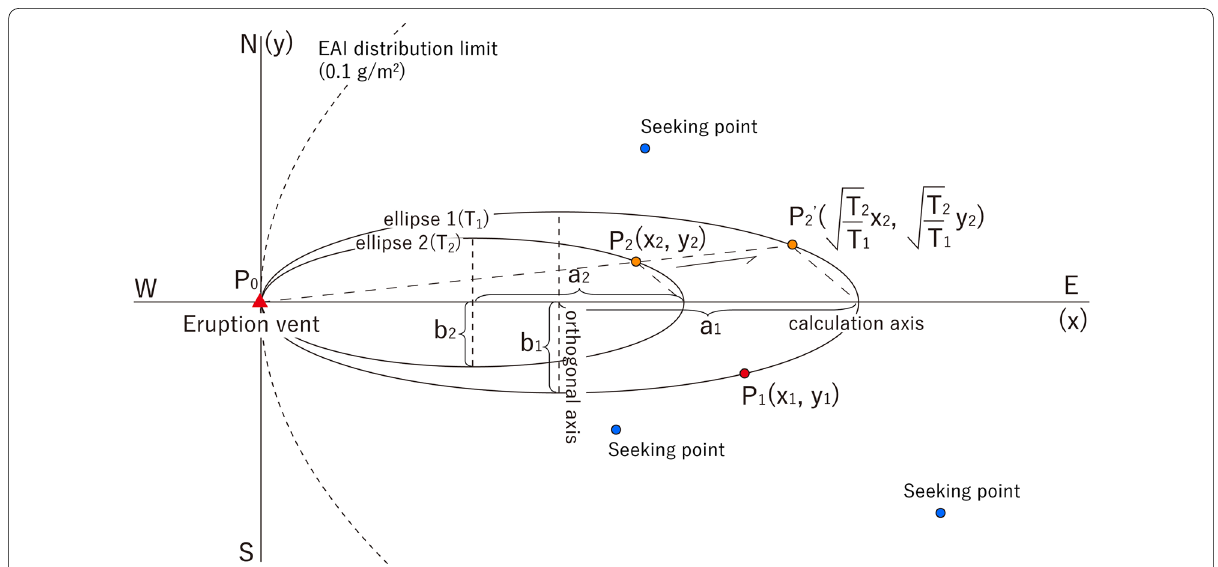
Fig. 3 Conceptional model of the ellipse-approximated isopach (EAI) analysis modified from Tajima et al. (2013b). Details are provided in the “EAI analysis method”